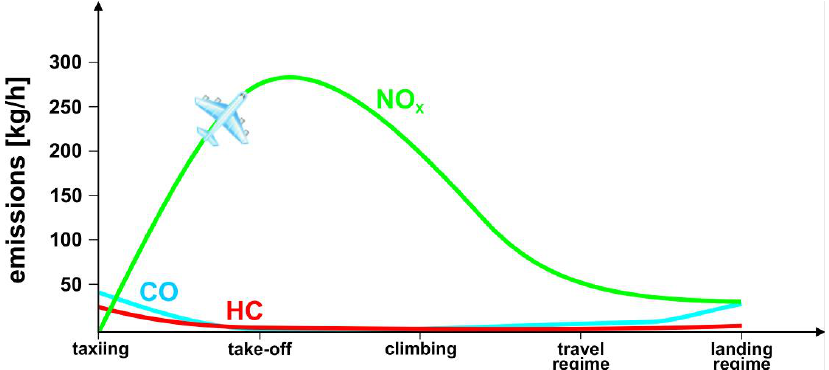
Figure 7 – Production of harmful pollutants during various jet engine working regimes (Kerner, Kul č ák, and Sýkora,